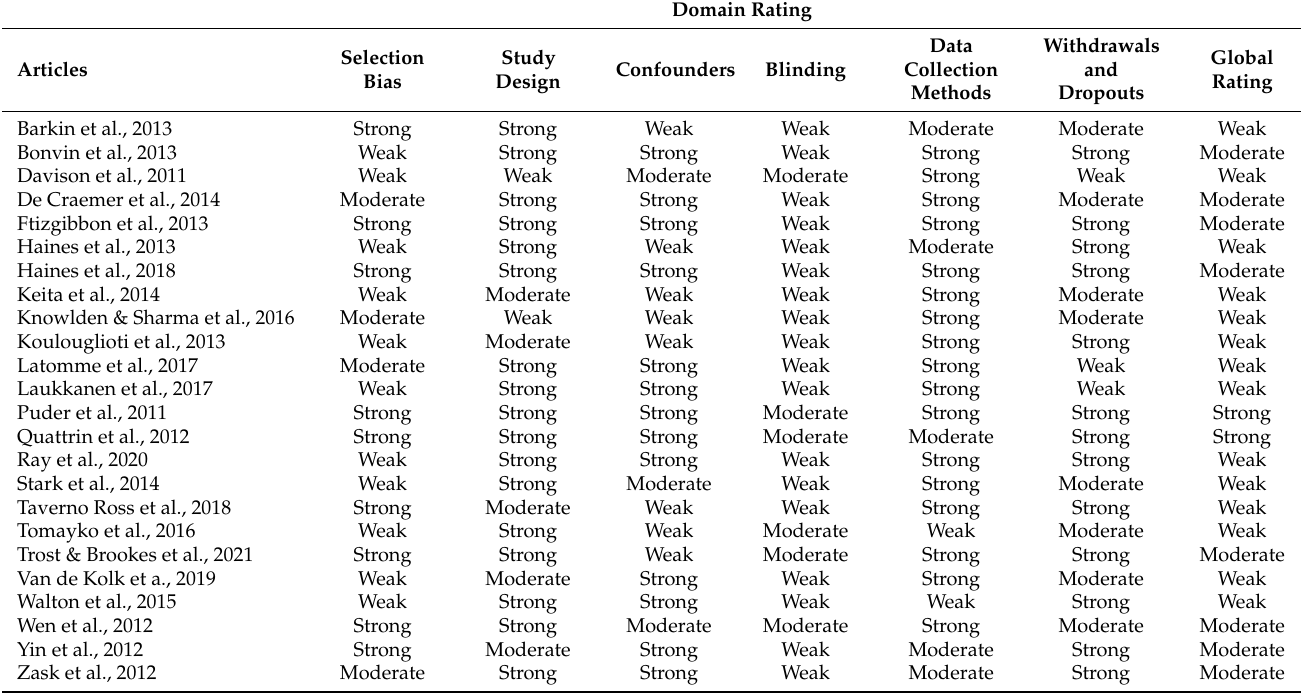
Table 1. Risk of bias assessment–EPHPP assessment